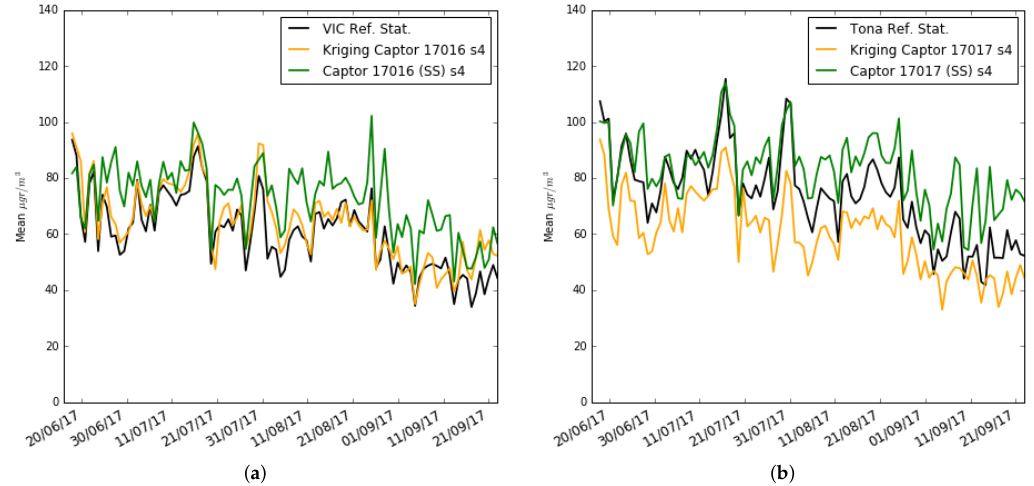
Figure 17. Case 3: Training set of 3 weeks: Mean ozone concentration for single-scale versus multi-scale with exact correction and Kriging estimation (daily), ( a ) in Captor 17016 (Vic), ( b ) in Captor 17017